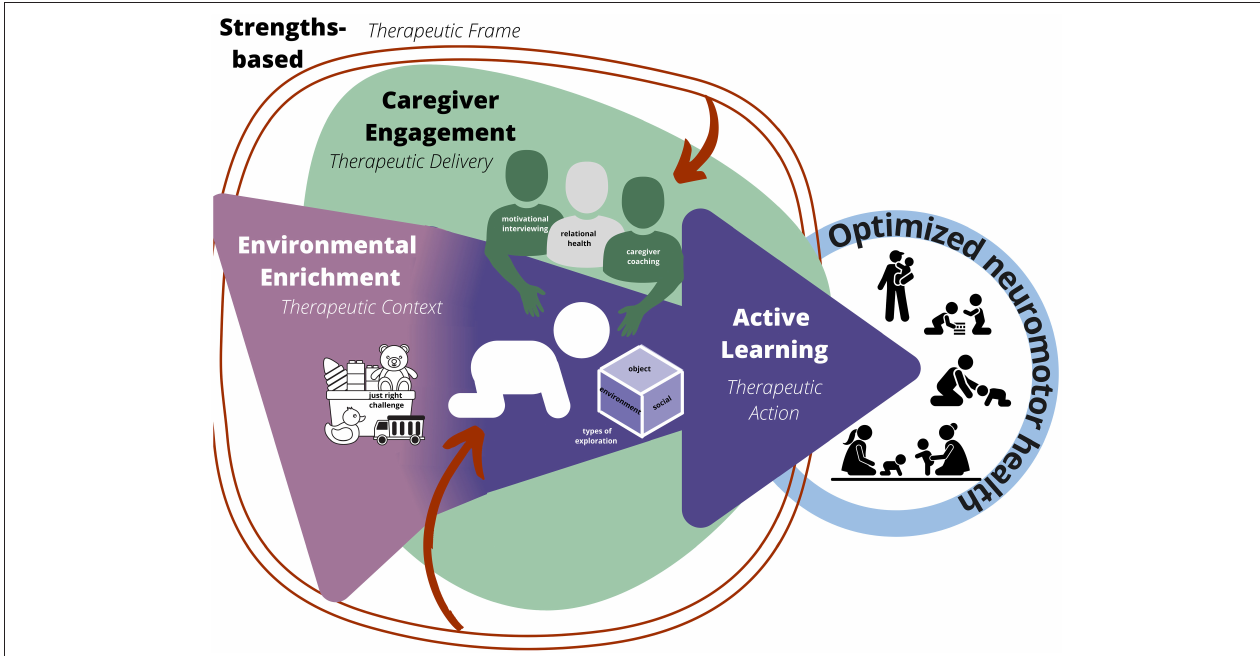
FIGURE 1 | CARES Framework. Active learning is the therapeutic action or mechanism (dark purple), environmental enrichment is the therapeutic context, creating opportunities for action to occur (light purple), caregiver engagement is therapeutic delivery of intervention (green), and strength-based approach is the therapeutic frame (red) influencing each